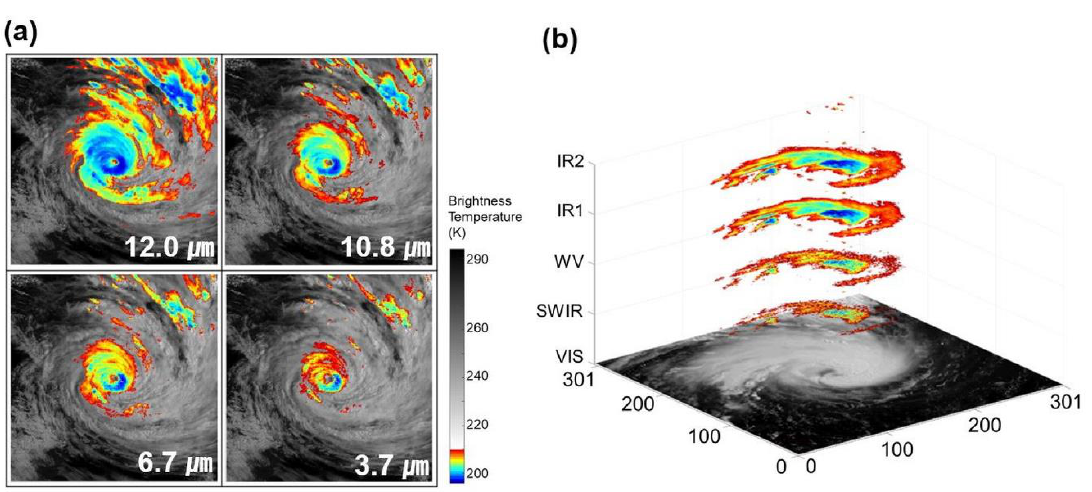
Figure 3. Deep convectional areas of four channels. They show the spiral patterns by channel—the lower 20% of the brightness temperature in each channel is indicated as relatively strong convection.